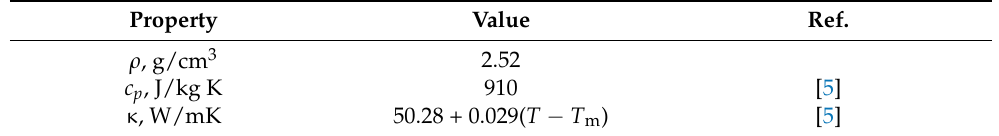
Table A3. Liquid -Si—thermophysical properties.